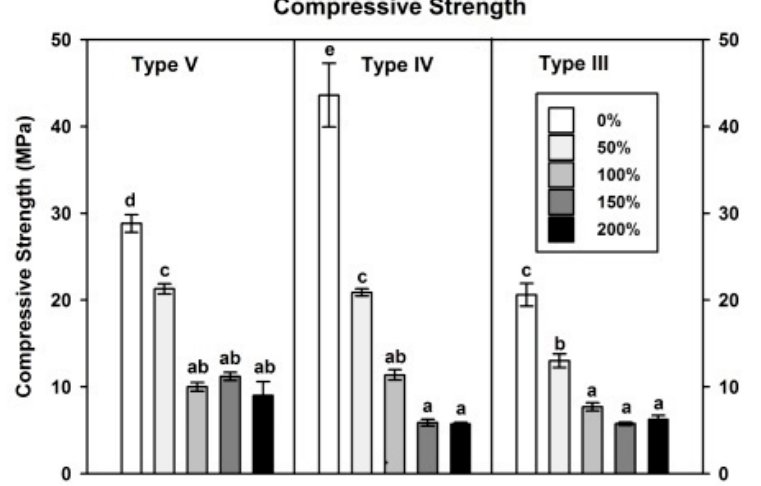
Figure 4. Bar chart of one-hour compressive strength for three gypsum types and five water dilutions. Error bars represent standard errors of means; groups with different letters are significantly different at α = 0.05 confidence level. Comparisons are both within and across gypsum types.